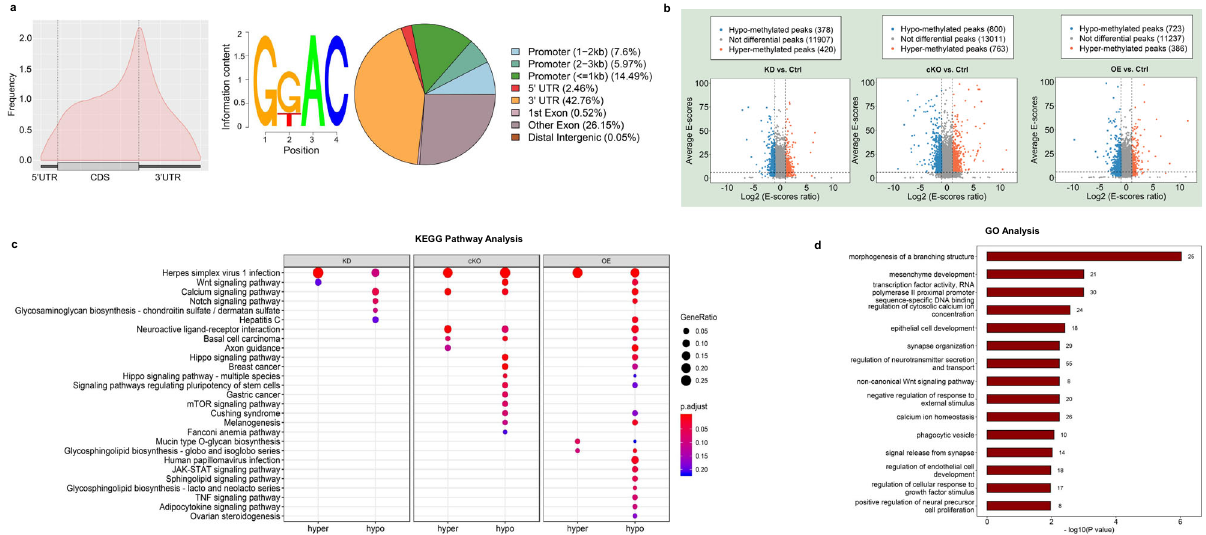
Fig. 3 Hippocampal m 6 A epitranscriptome modi fi ed by FTO. a Left: distribution of m 6 A peaks throughout the whole mRNA transcript; middle: the most abundant motifs detected in peaks and enriched at peak summits; right: annotation of peaks detected in cKO mice. b Differentially methylated peaks among different groups. c KEGG pathway analysis of differentially methylated genes in different groups. d GO analysis of genes with hypomethylated peaks in OE